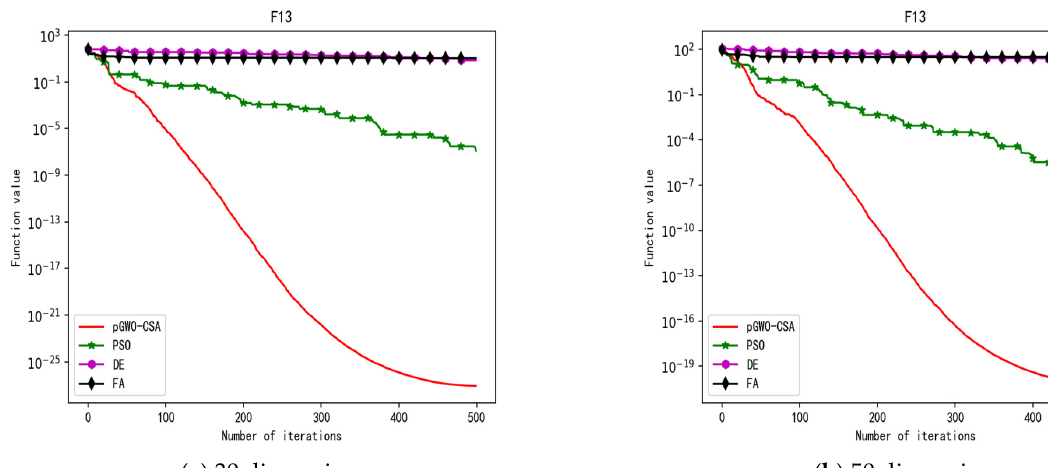
Figure 17. Convergence curve of test function F13.